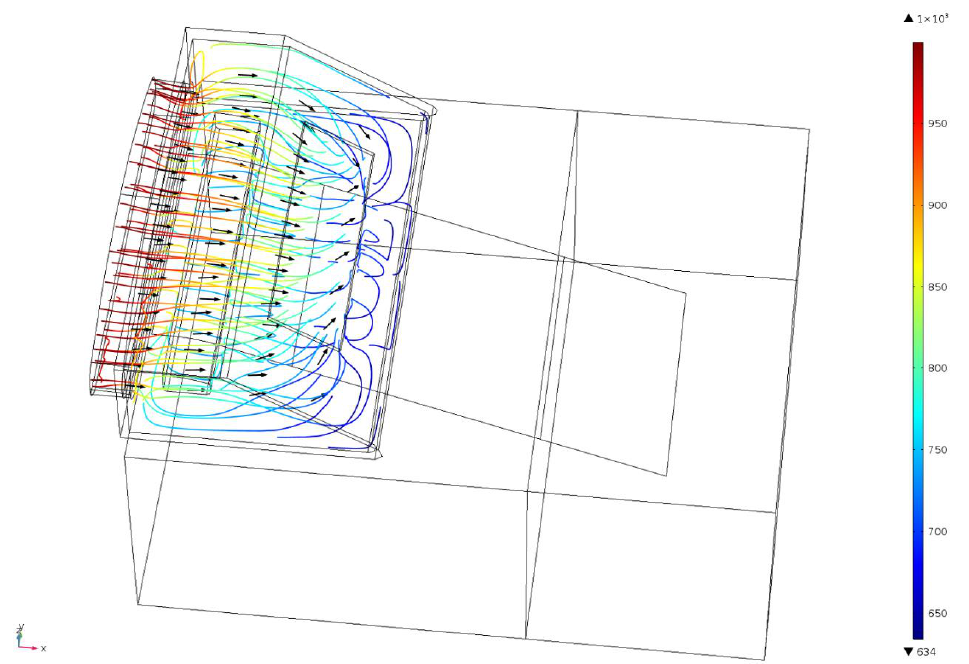
Figure 4. Numerical results of the hydrogen gas flow with its temperature (°C ) . Gas inlet position: surface A in Figure 2, 𝑄 = 2.66 Nm 3 /h , Strip velocity = 𝑣 𝑆𝑡𝑟𝑖𝑝 (< 0.17 m/s) .